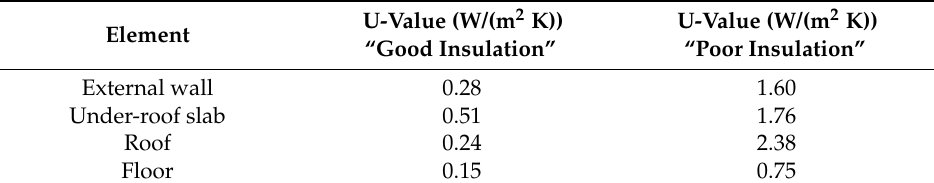
Table 2. Thermal transmittance value of opaque elements of the building envelope for “Good insulation” and “Poor insulation” buildings. Table 3. Thermal properties of windows for “Good insulation” and “Poor insulation” buildings.